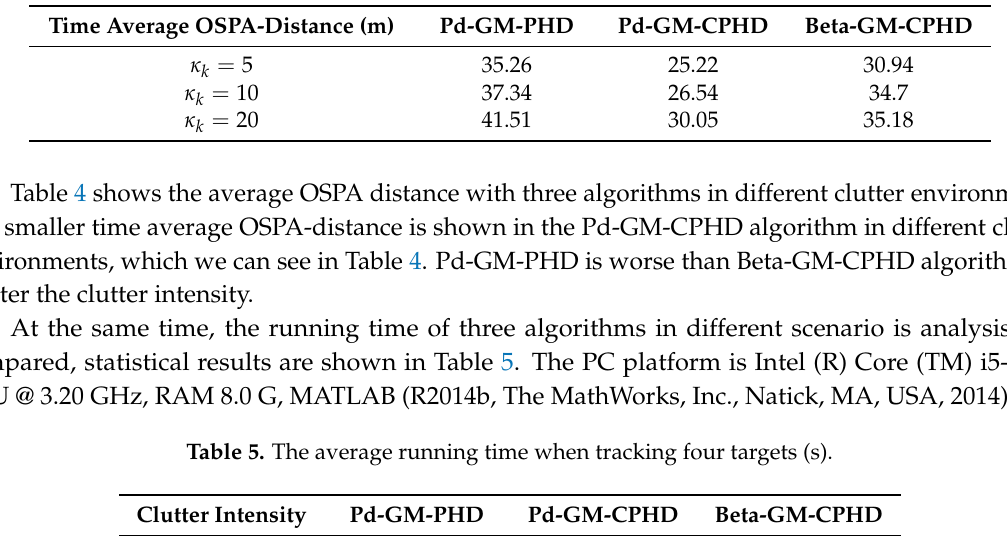
Table 4. Comparison of time average OSPA-distance (m) in different clutter environments.